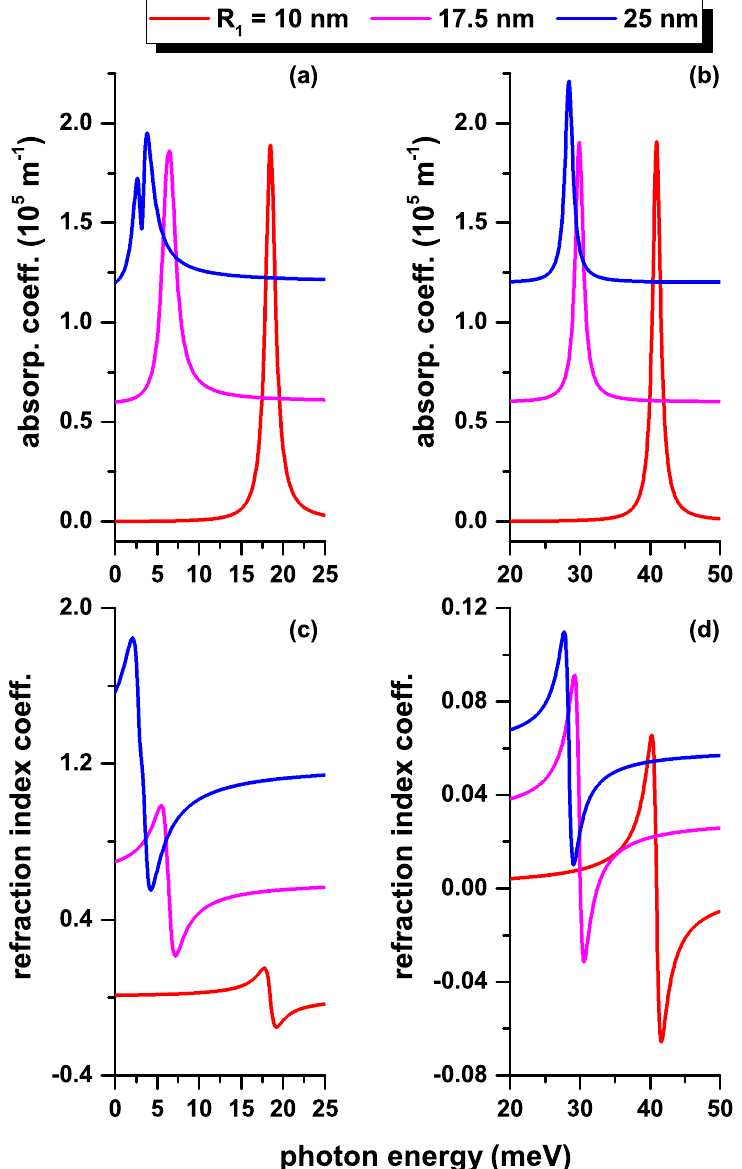
Figure 10. (color online) The total optical absorption coefficient ( a , b ) and the total relative changes of the refraction index coefficient ( c , d ) as functions of the incident photon energy in a CdS/ZnS spherical QD with several values of the R 1 -inner radius. Results are without ( a , c ) and with ( b , d ) on-center donor impurity, with R 2 = 30nm. Optical transitions are between the lowest confined l = 0 states without electric and MF